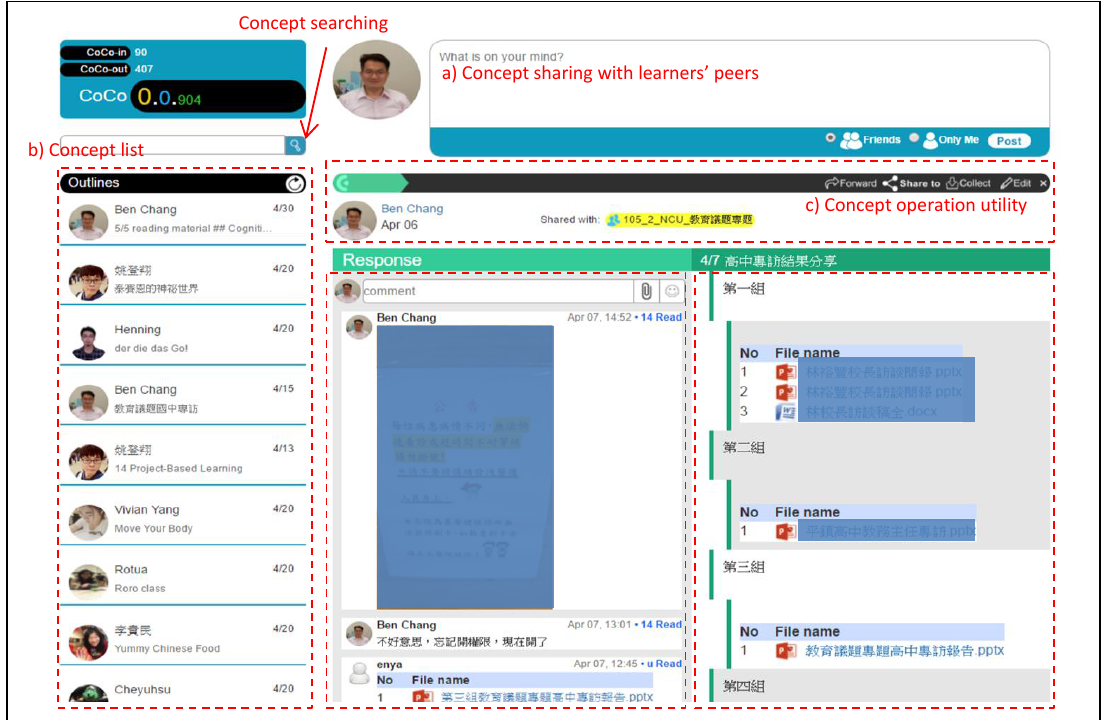
Figure 5. Concept list interface on a personal computer